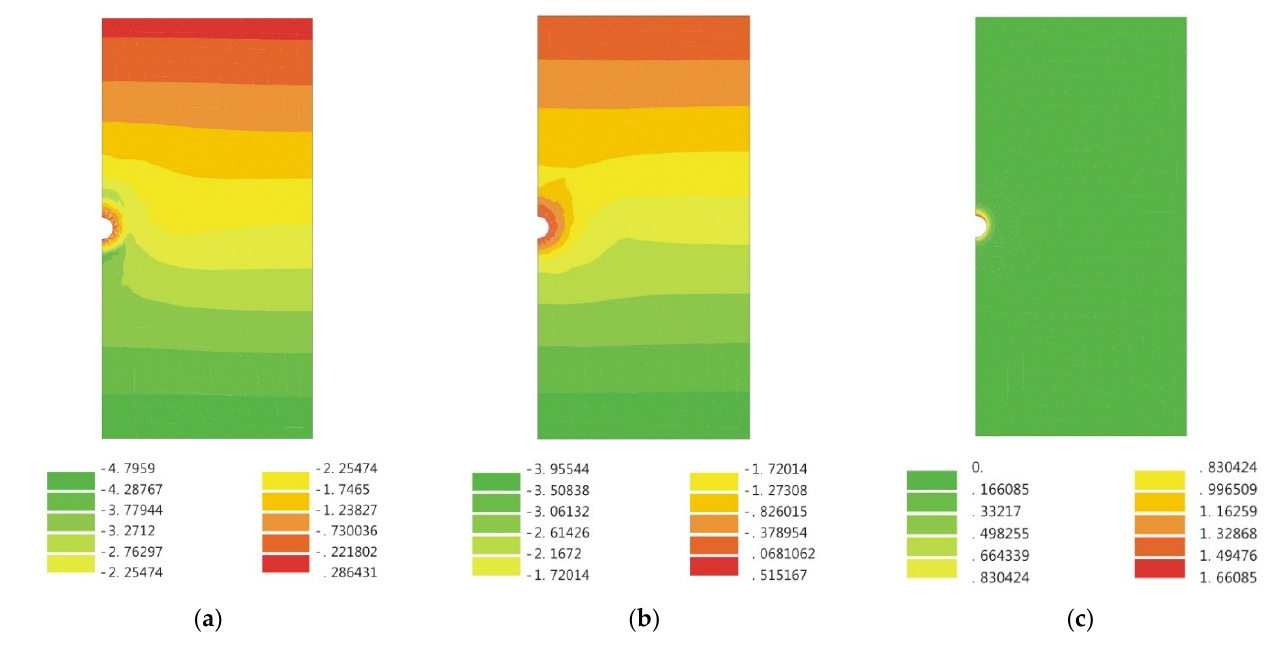
Figure 10. Iso-value contour plots of the final stress/displacement distribution around the tunnel under the initial anisotropic stress condition ( K o = 1.2) in finite element analysis. ( a ) Major Principal stress (MPa), ( b ) Minor Principal stress (MPa), and ( c ) total displacement (m).